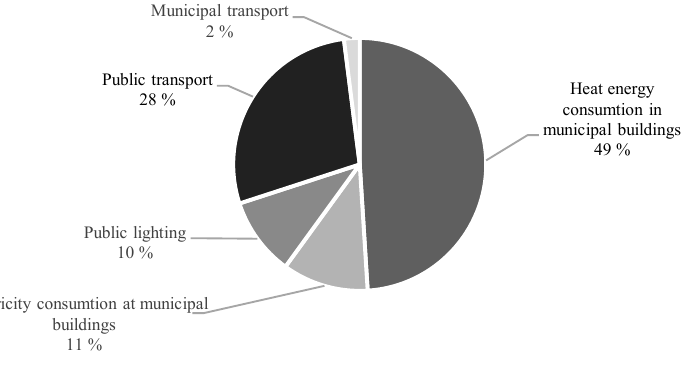
Fig. 3. Distribution of municipal energy consumption in Daugavpils in